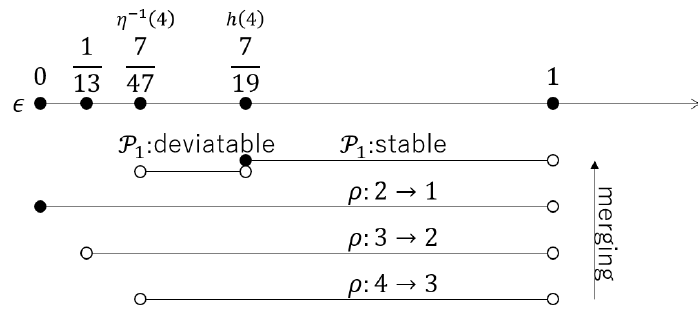
Figure 3. Cost advantage, stability, and cartel formation among four